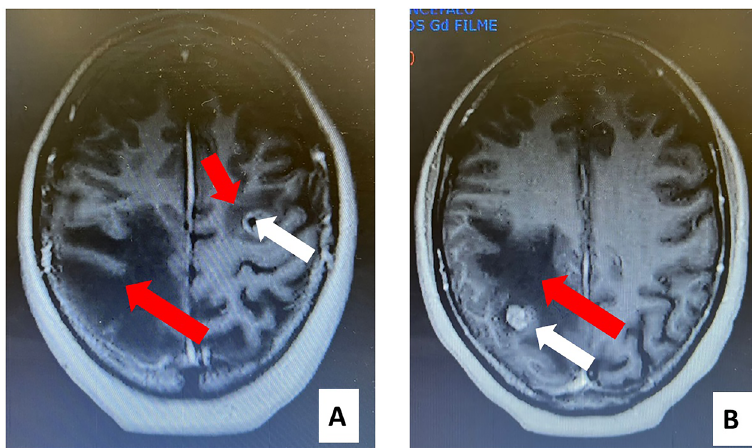
Figure 4. A. CT scan showing a mass at left temporal lobe (white narrow) and edema surrounding the mass and in the contralateral hemisphere (red narrows). B. CT scan showing a mass at right parieto-occipital lobe (white narrow) and edema surrounding the mass (red narrow). It is possible to visualize that the expansive effect of the mass determines regional erasure of sulcus and fissures without deviation of the centromedian